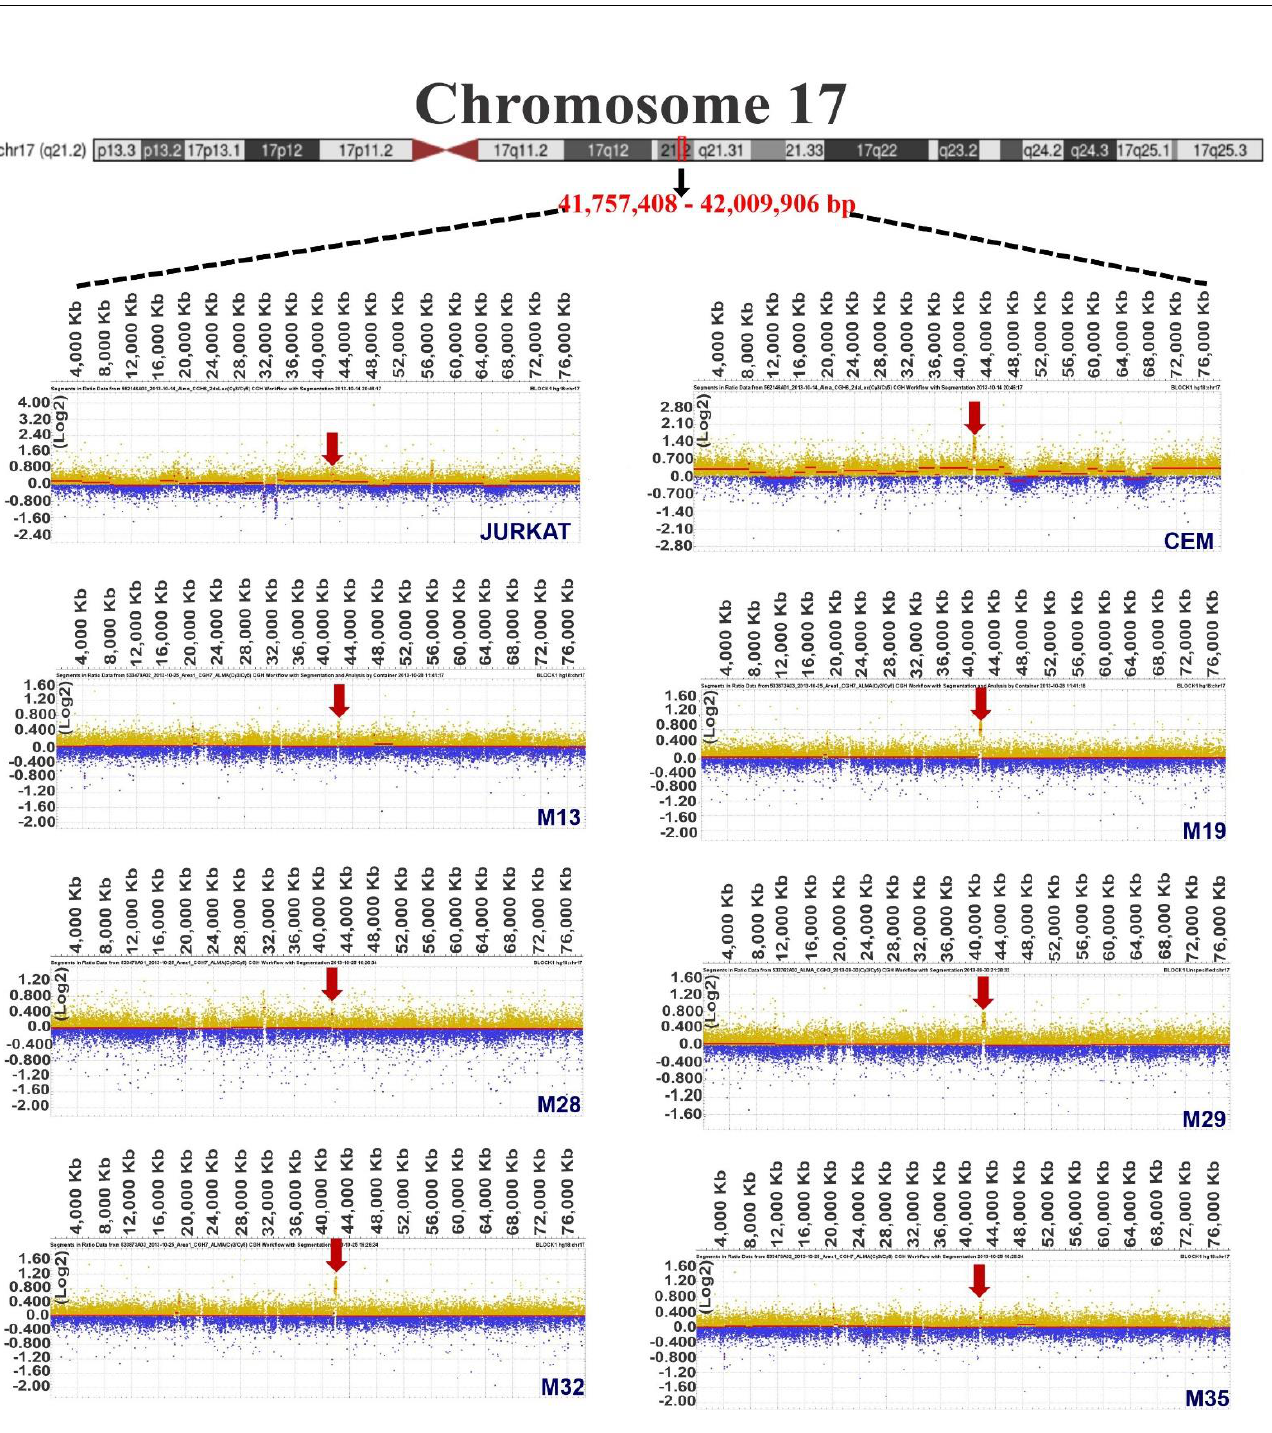
Figure 2. Comparative genomic hybridization images of gains observed for chromosome 17. The ideogram of chromosome 17 shows the common gain region on the q21.2 arm with dotted lines. Representative images of each patient or cell line were obtained with DEVA software; gains are indicated by red arrows, and signal intensity values (ratios) were normalized with Log2. The size scale is shown in megabases (Mb). The patient ID is included in the lower-right margin of each image.